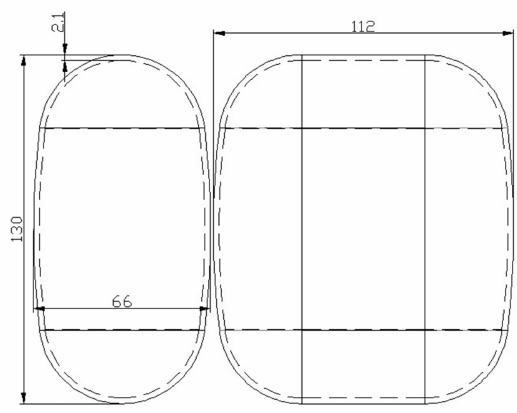
Figure 2. Shape and dimension of the conventional storage